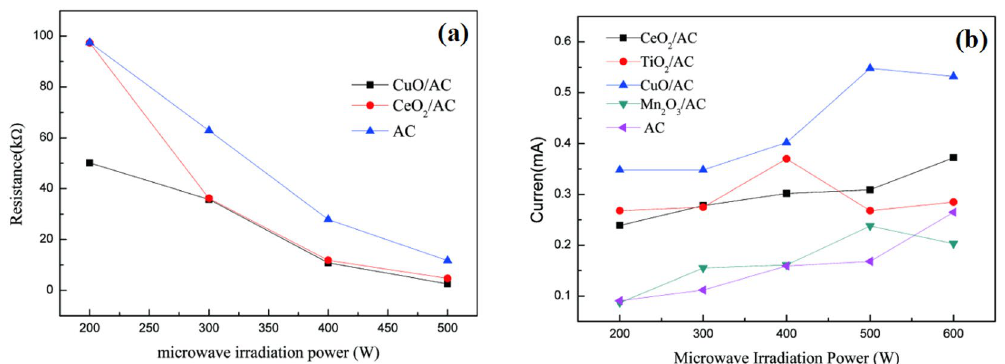
Figure 2. The change of conductivity with P MW ( a ) and the change of conductivity with P MW ( b